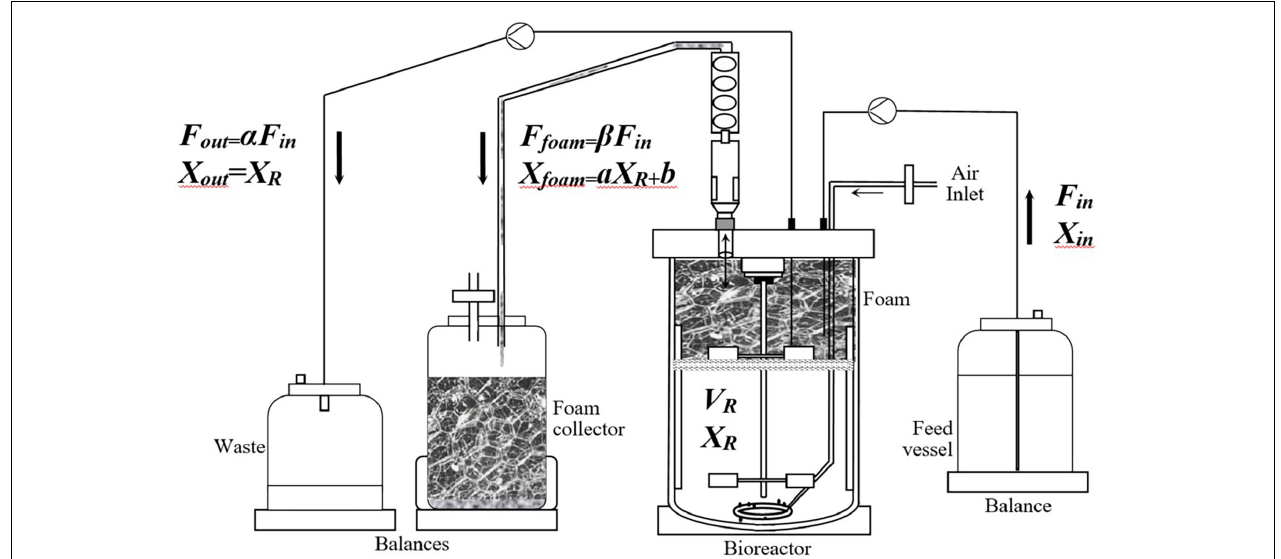
FIGURE 1 | Flow sheet of the overflowing continuous culture